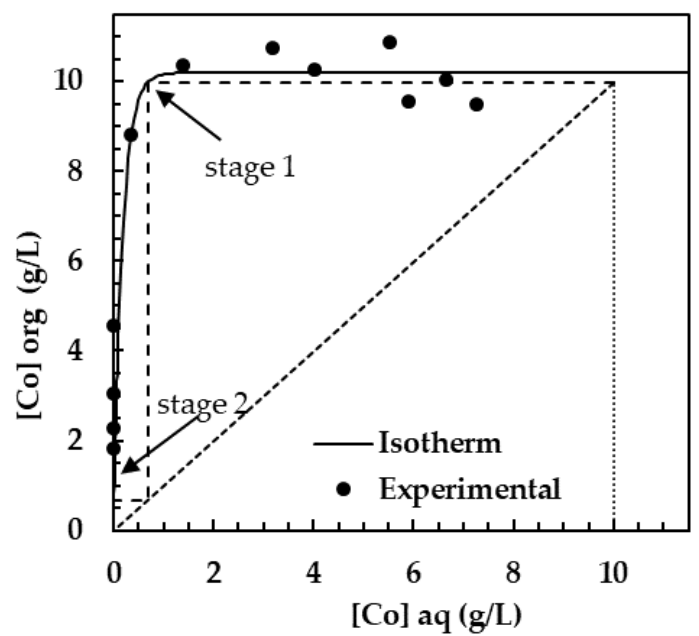
Figure 10. Extraction stages at A/O = 1, Xi = 10 g/L, Xf = 12.18 mg/L, [Cyanex 272] = 0.4 mol/L, pH = 6, time = 10 min, and temperature = 22 ± 1 °C.